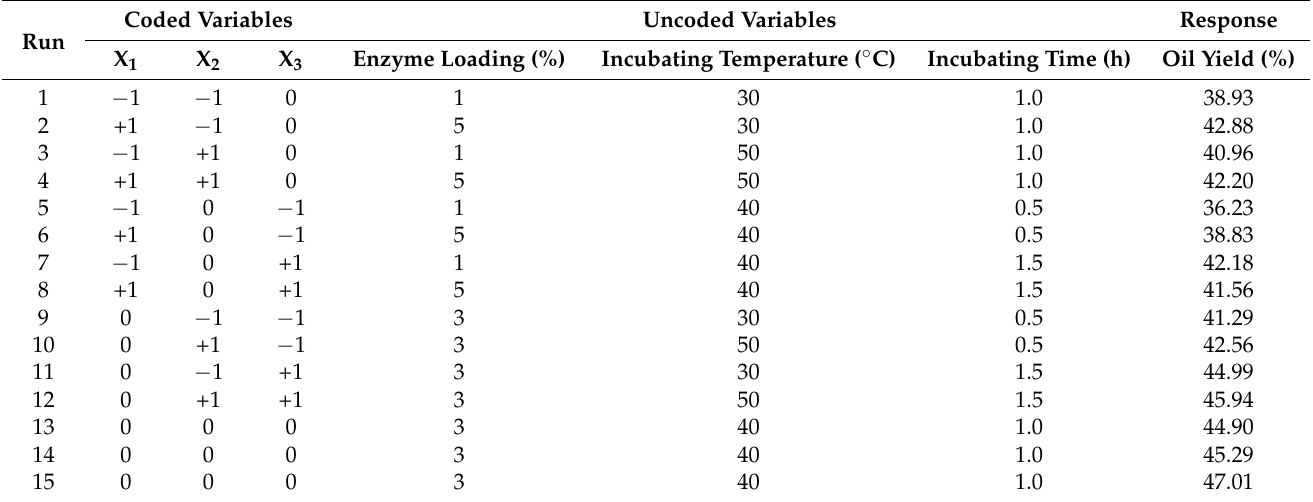
Table 2. Box–Behnken design matrix in coded and uncoded values and